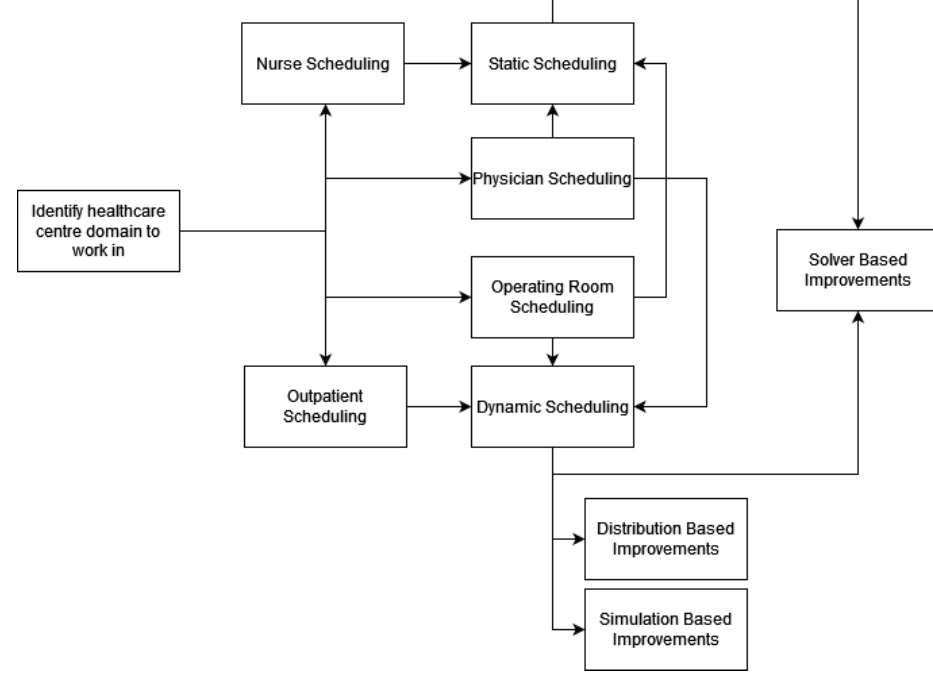
Figure 3. A flowchart of decisions to be made when choosing the problem domain.